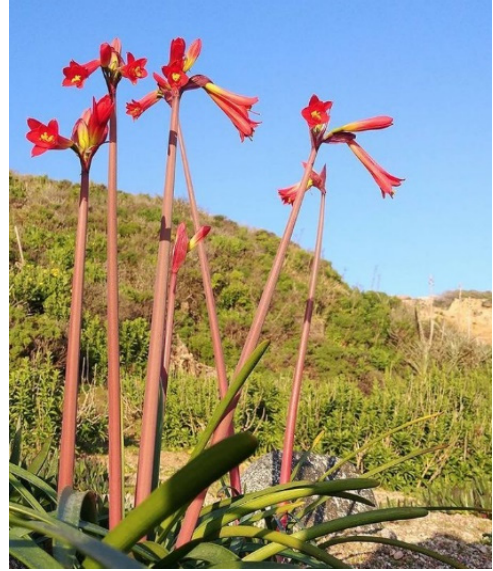
Figure 1. Phycella cyrtanthoides (Amaryllidaceae) plants.